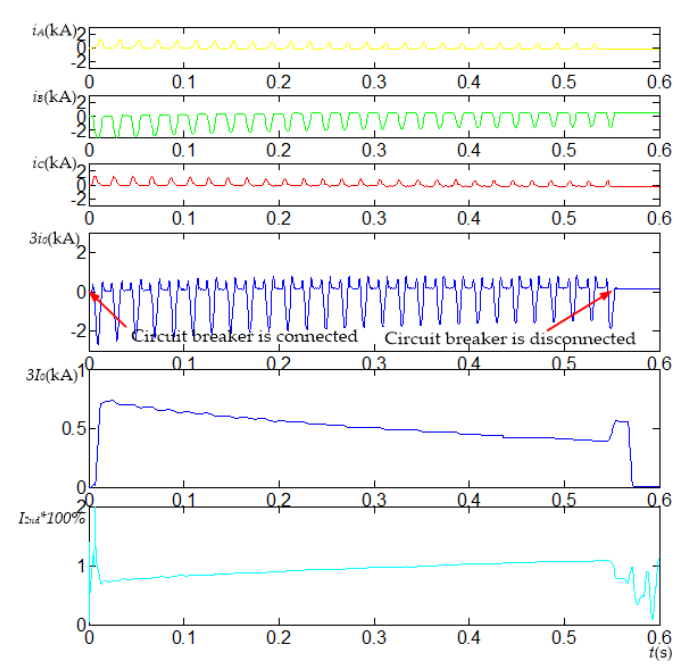
Figure A5. Recorded waveform No. 4 (0 s–0.6 s).